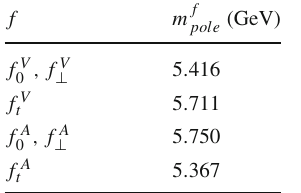
Table 4 Values of B meson pole masses m f pole